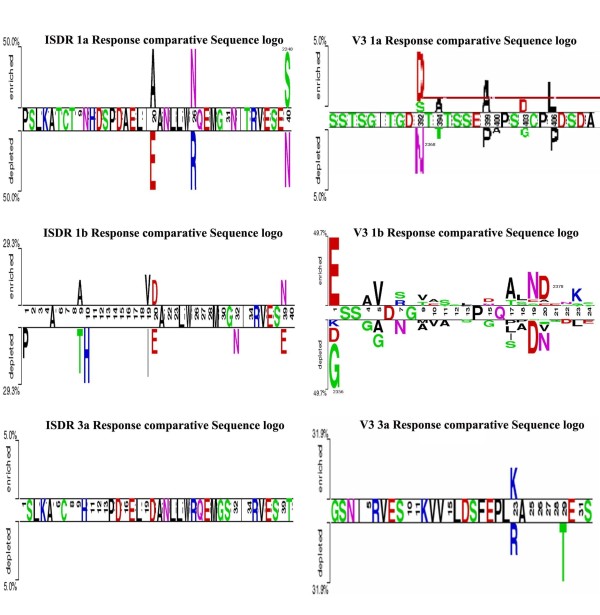
Comparative sequence logos for the ISDR and V3 regions. In the figure, the letters in the middle bar represent conserved positions. The totally empty positions represent variations within each group but no considerable variations between the two groups. The non-responders were set as the negative sample and the responders as the positive sample.